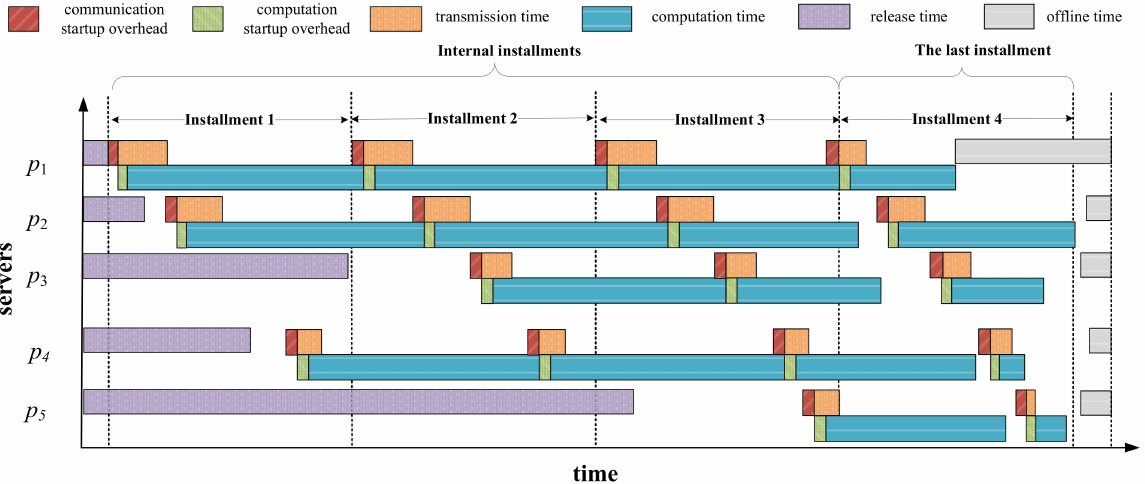
Figure 6. An example of the case when early > later .